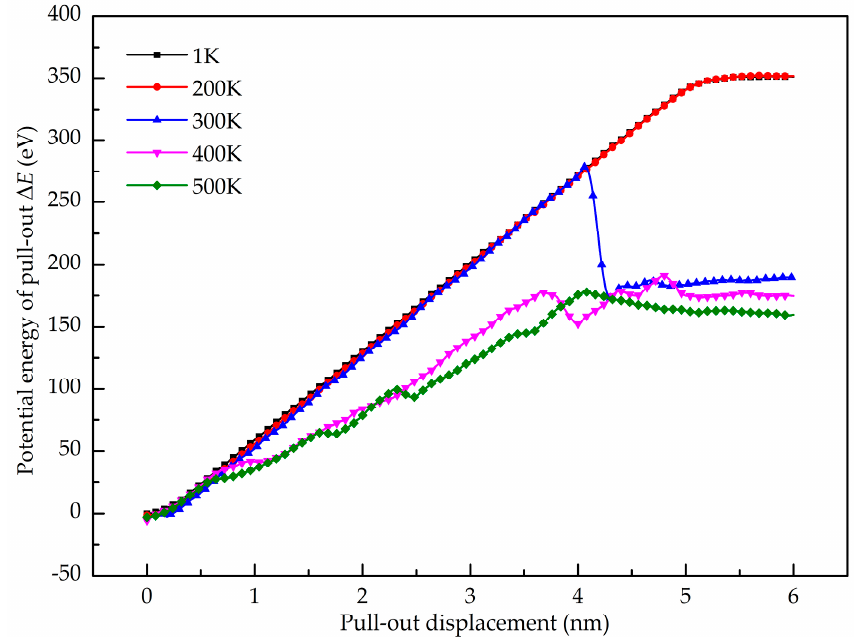
Nanomaterials 2018 , 8 , x FOR PEER REVIEW Figure 11. Potential energy increment during pull-out test under different temperature.